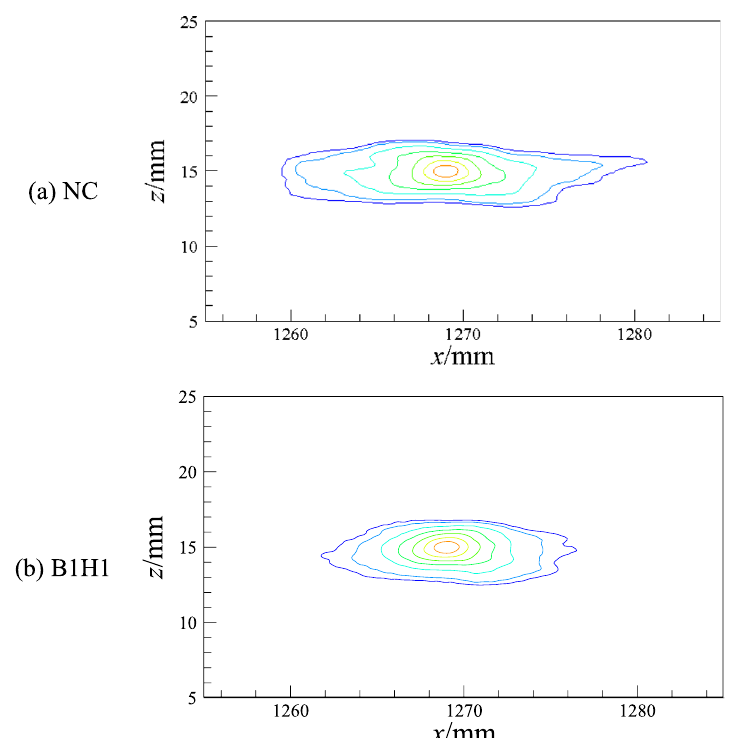
Fig. 18 Two-point correlation coefficient of streamwise fluctuating velocity in x - z plane at y +